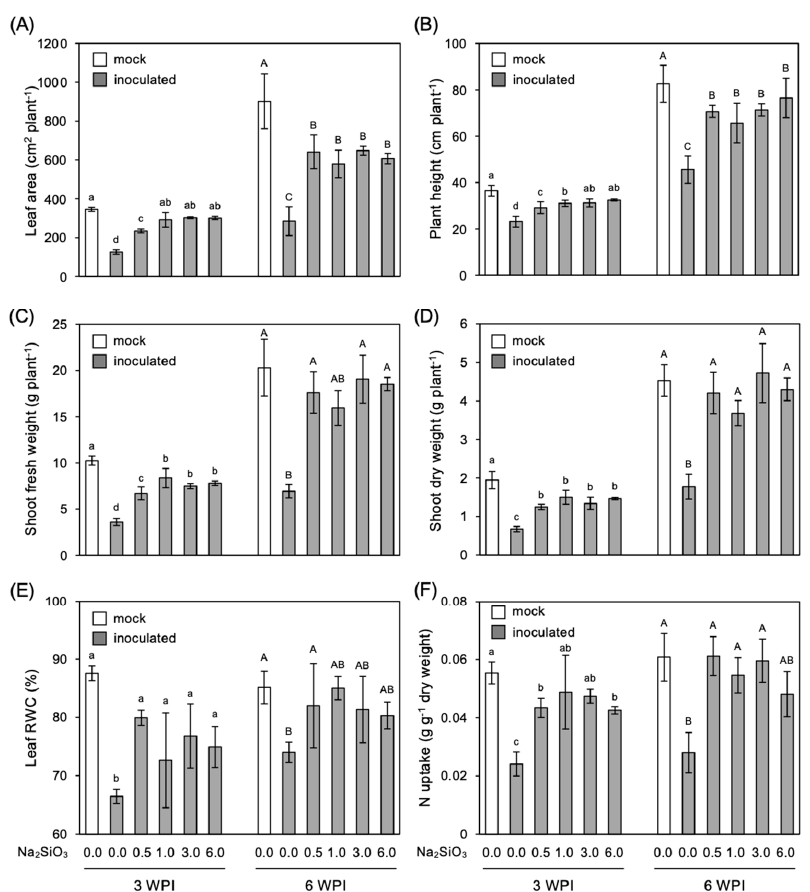
Figure 3. Leaf area ( A ), plant height ( B ), shoot FW ( C ), shoot DW ( D ), leaf RWC ( E ), and N uptake ( F ) of soybean plants at 3 and 6 WPI with Calonectria ilicicola ( n = 12). Different lowercase letters indicate significant differences among treatments ( P < 0.05), as per Tukey’s HSD test. Root growth parameters were also significantly ( P < 0.05) reduced in response to RCR; FWs decreased by 63% and 68%, surface area decreased by 25% and 64%, total length decreased by 43% and 64%, and total tip number decreased by 31% and 71% at 3 and 6 WPI, respectively (Figure 4). However, again, root growth parameters, except for total tip number, were effectively restored by Si treatment (Figure 4).